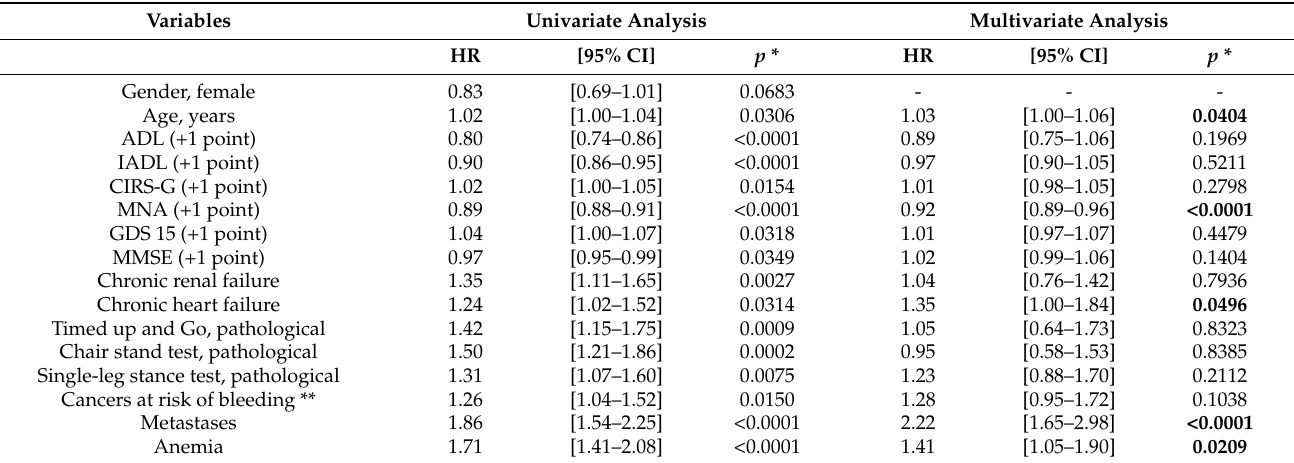
Table 2. General characteristics related to overall survival.